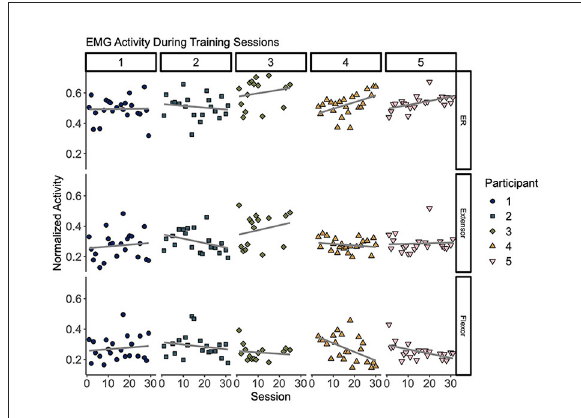
FIGURE5 Muscle activity during remote training sessions. Each column (1–5) represents per-session averages (markers) of muscle activity (rows) during training for each participant. (Top) Muscle individuation (ER) where values closer to 1 indicate higher extension activity and values closer to 0 indicate higher flexion activity. (Middle) Normalized extensor electromyography (EMG) activity. (Bottom) Normalized flexor EMG. Overall, these plots suggest modest trends of improved individuation over time ( top row ). Changes of ER over time showed a significant increase for Participants 4 ( p = 0.018) and 5 ( p = 0.013). This change was accompanied by a decrease of flexor activity over time ( p = 0.009 for Participant 4 and p = 0.016 for Participant 5). Best fit lines are included to visualize trends across sessions in gray.